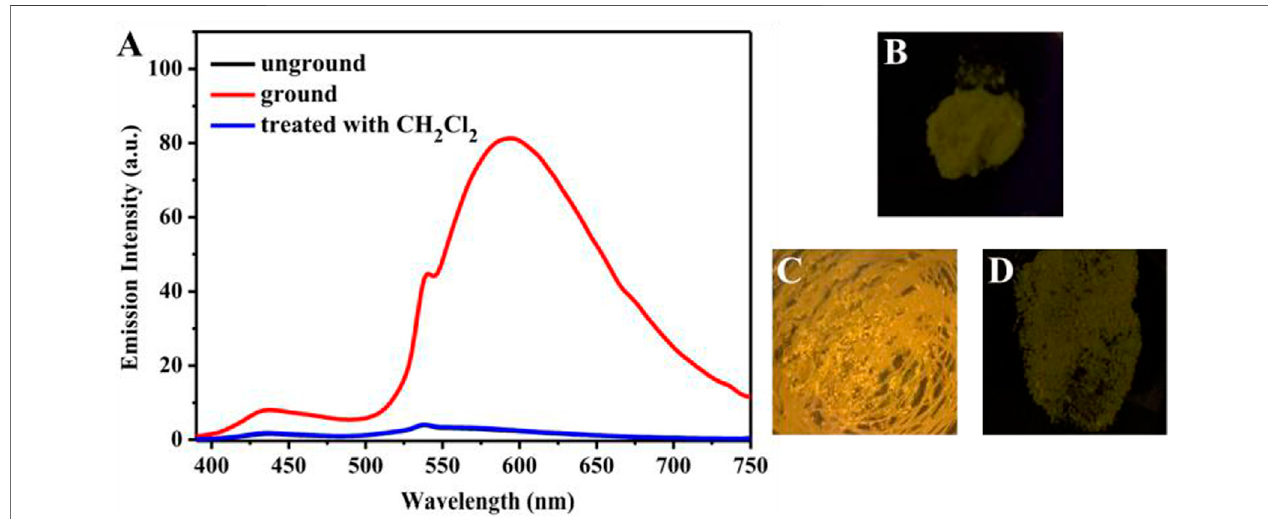
FIGURE 6 | (A) Fluorescence spectra of solid sample 1 before grinding, after grinding, after treatment with dichloromethane vapor. The excitation wavelength is 365 nm. Fluorescence images of sample 1 in various states under 365 nm UV light: (B) as-synthesized sample, (C) ground sample, (D) sample after treatment with dichloromethane vapor.